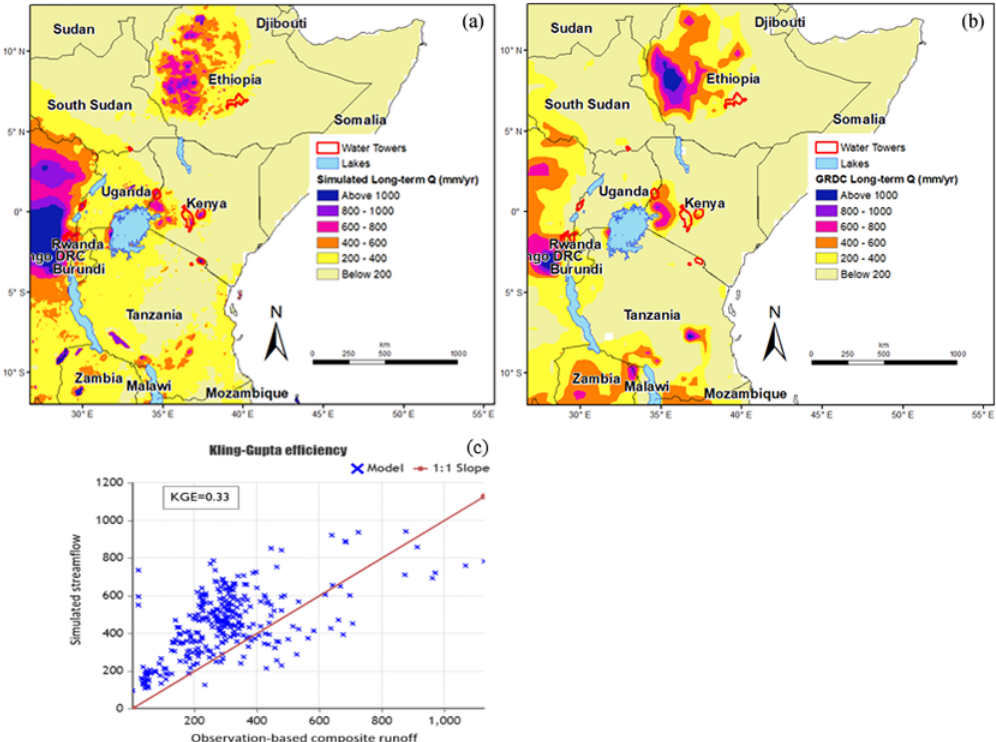
Figure 8. Comparison of simulated streamflow and observation-based runoff. (a) Simulated streamflow, (b) observation-based composite runoff, and (c) Kling–Gupta efficiency calculation are